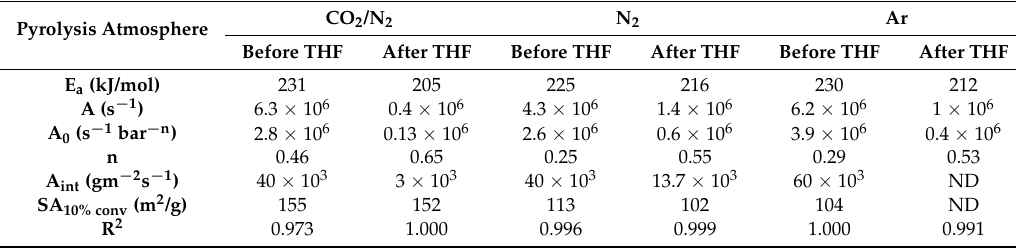
Table 7. Kinetic parameters for the chars generated in various pyrolysis atmospheres (at 10% conversion).